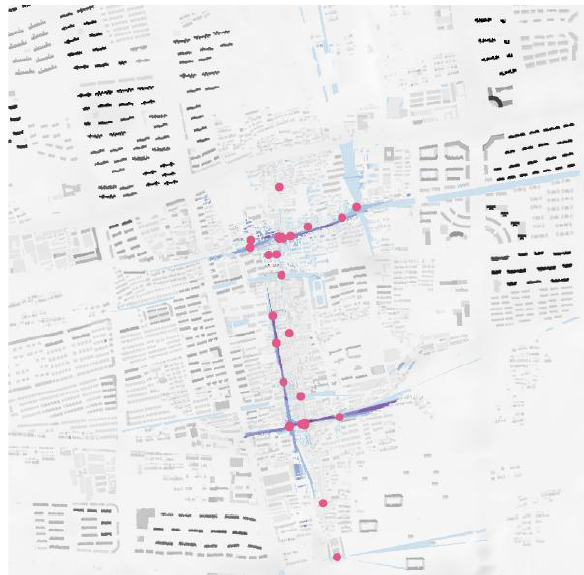
Figure 10 . The combined viewshed map in Xinchang Ancient Town. Generated with QGIS with the visibility analysis plug- in. Darker purple color stands for more chances to be seen.